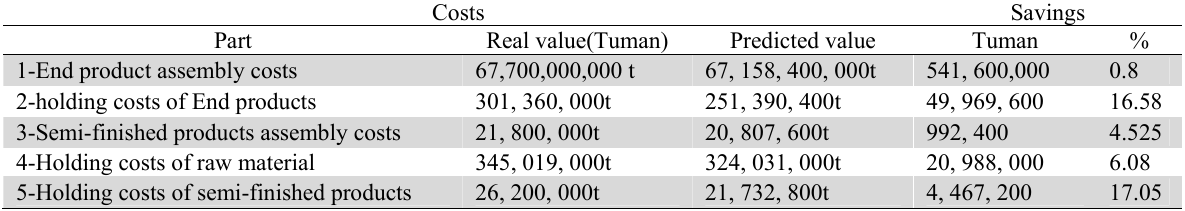
Costs and Savings (Peugeot 405Glx and Peugeot Pars) Costs Savings